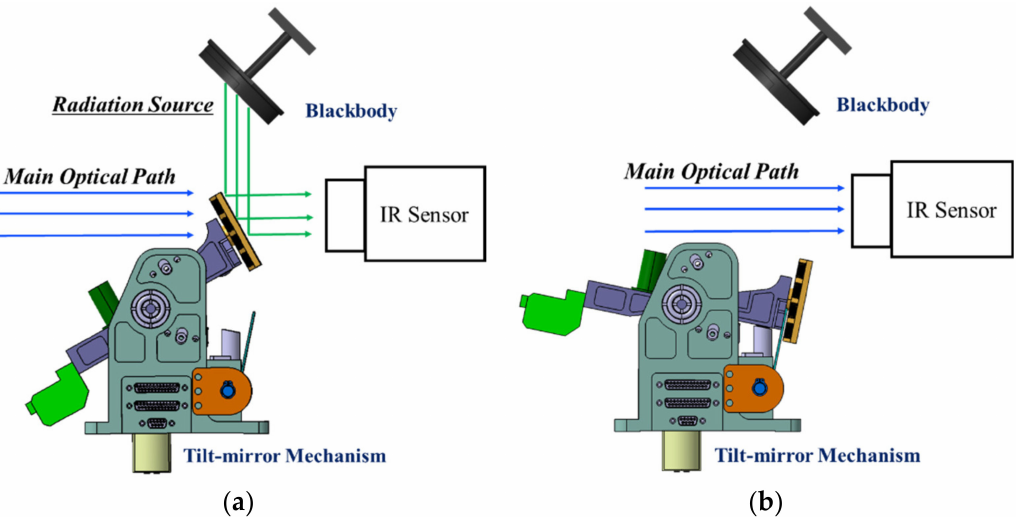
Figure 1. On-board calibration concept using BB and tilt-mirror ( a ) Imaging mode; ( b ) calibration